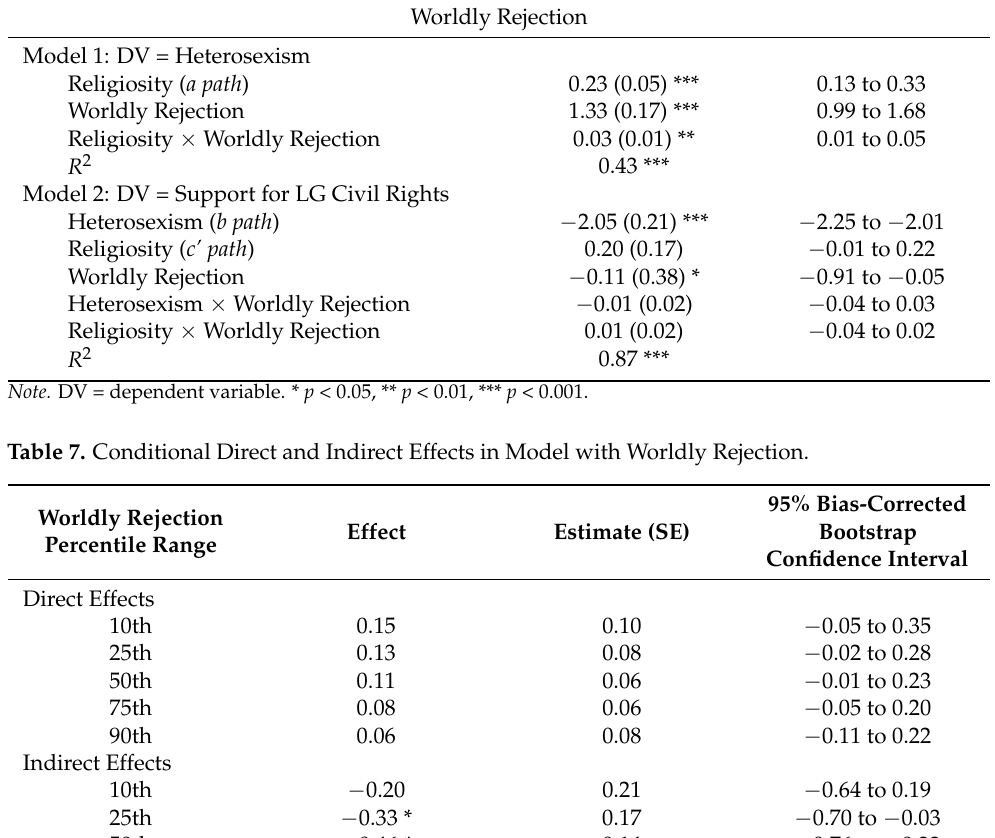
95% Bias-Corrected Estimate (SE) Bootstrap Confidence Interval